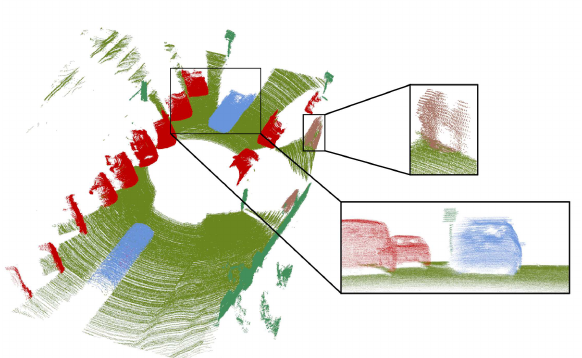
Figure 8: Demonstration of detecting different moving and static object regions in the point cloud. Color codes: dark green - static objects, light green - ground, red - static vehicles, blue - moving vehicles, light brown - moving